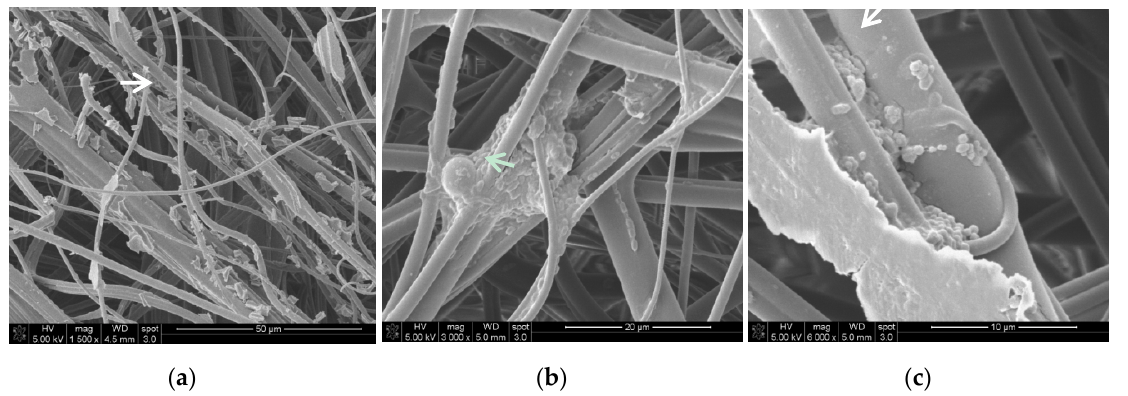
Figure 1. Biofilm on reusable FFR: ( a ) FFR fibres with visible dust particles; ( b ) bacterial and fungal biofilm with extracellular polymeric substances (EPS); ( c ) bacterial biofilm coexisting with organic dust particles (SEM images 1500–6000×).